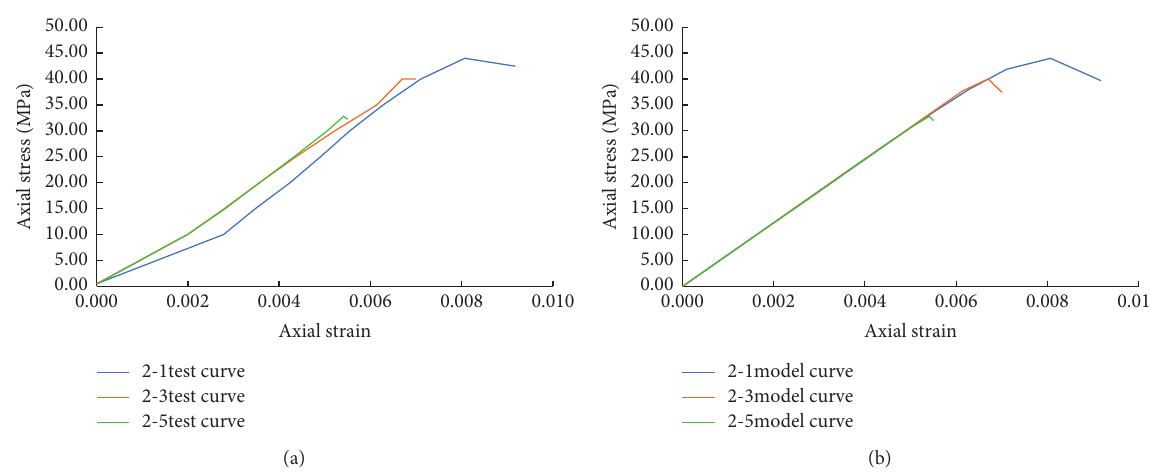
Figure 4: Stress-strain curve (I) of filled cracked rocks with cement mortar ( σ